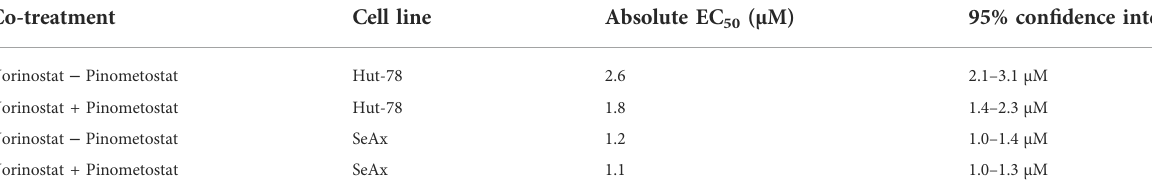
TABLE 2 EC 50 values after co-treatment with HDAC and DOT1L inhibitor.